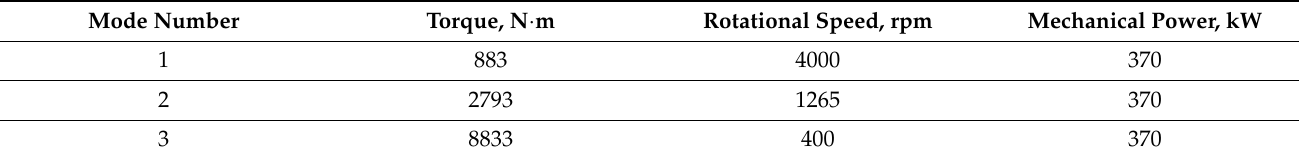
Table 1. Operating points of the traction motor considered during the